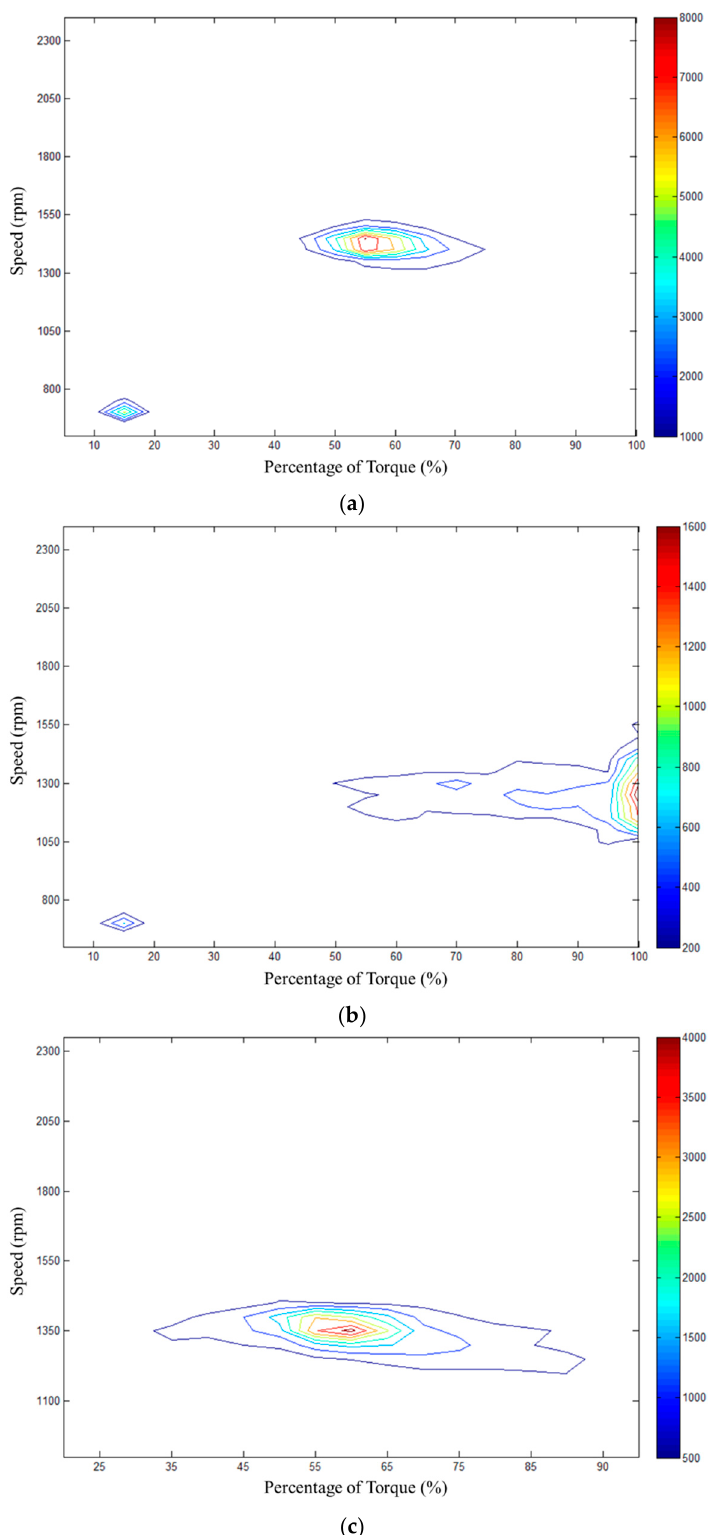
Figure 5. Distribution of the operating conditions from vehicle real road test. ( a ) Case 1: Distribution of the operating conditions from Yancheng to Zhengzhou; ( b ) Case 2: Distribution of the operating conditions from Zhengzhou to Xi’an; ( c ) Case 3: Distribution of the operating conditions from Xi’an to Xining.